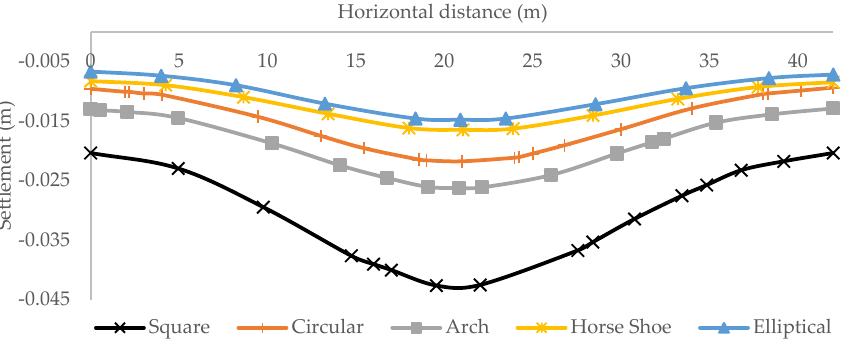
Figure 12. Ground-settlement trough for different shapes of tunnel linings.